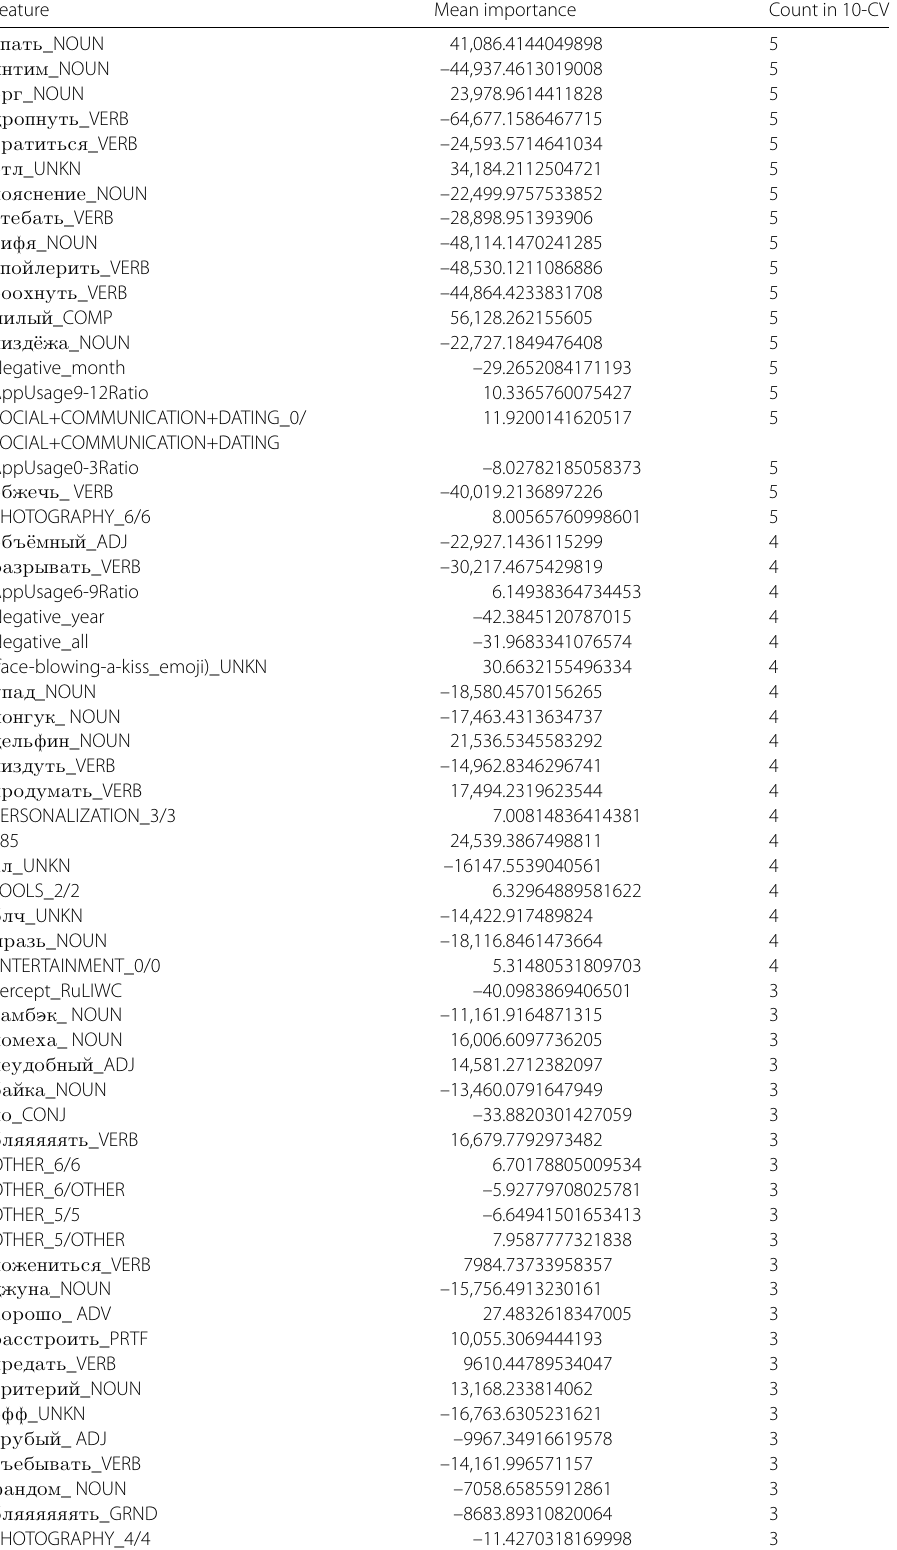
Table 22 Features significant in SWLS regression